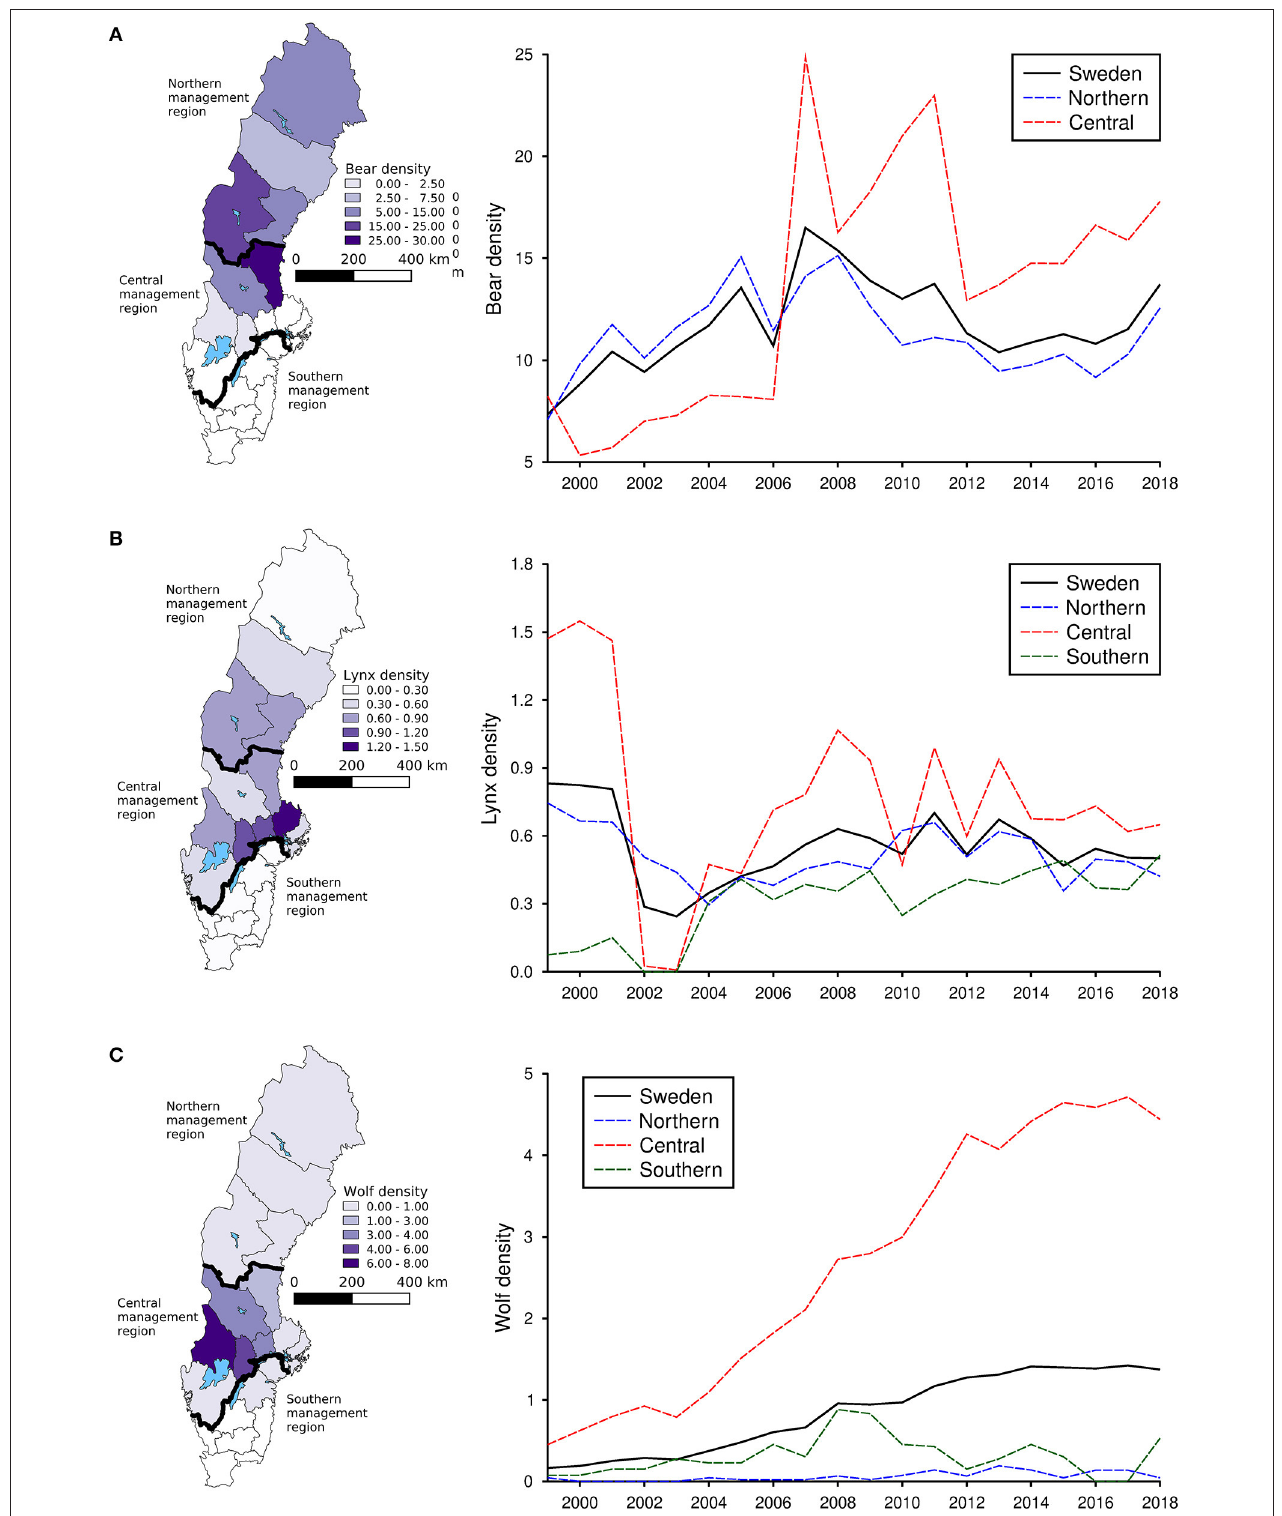
FIGURE 1 | Average densities of brown bear (A) , Eurasian lynx (B) , and gray wolf (C) in each county of Sweden from 1999 to 2018 as well as the national and regional trends for the same time period. Densities of bears represent number of bears per 1,000 km 2 , densities for lynx represents number of family units (i.e., mothers with offspring) per 1,000 km 2 and densities for wolves represents number of packs or territorial pairs per 1,000 km 2 . Densities were calculated for each spatial scale as the number of animals divided by the total area of each specific spatial unit (i.e., Sweden, each management region, or, in the maps, each county).